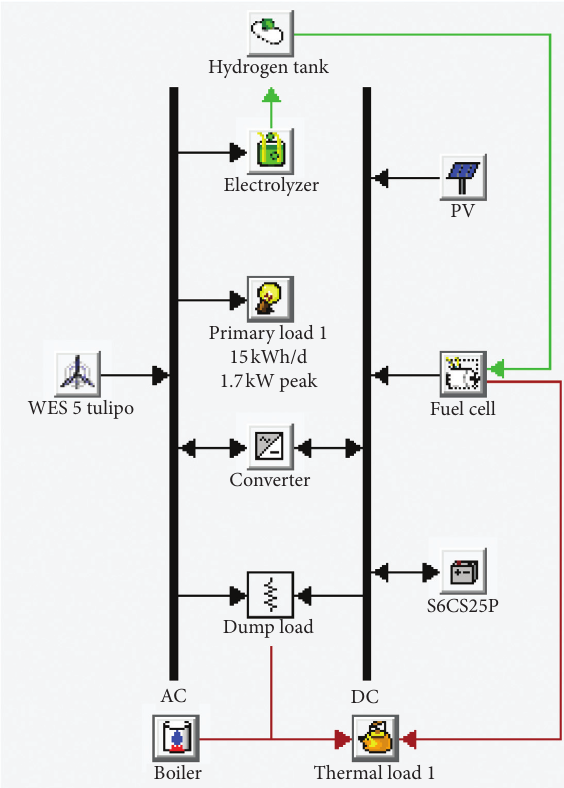
Figure 8: Schematic of understudy system.